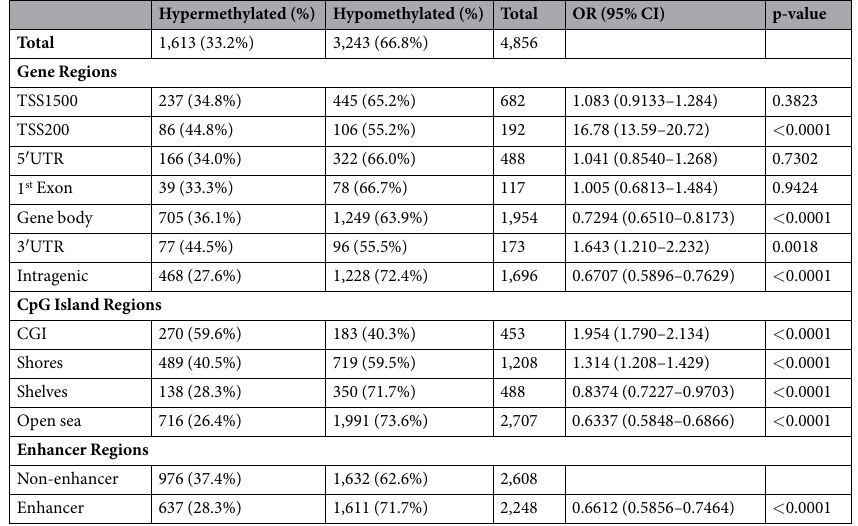
Table 2. The percentage of hypermethylated or hypomethylated differentially methylated cytosines (DMC) in each or the annotated